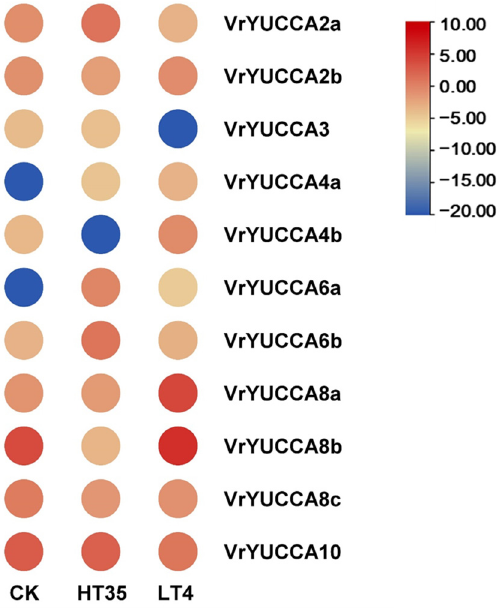
Figure 8. VrYUCCA genes expression during high and low temperatures. Values (RNA-seq data), in fragments per kilobase of transcript per million reads mapped (FPKM), used logarithm (LOG 2) for the heat map. CK: seedlings grown under 25 ◦ C; HT35: seedlings grown under high temperatures, 35 ◦ C; LT4, seedlings grown under low temperatures, 4 ◦